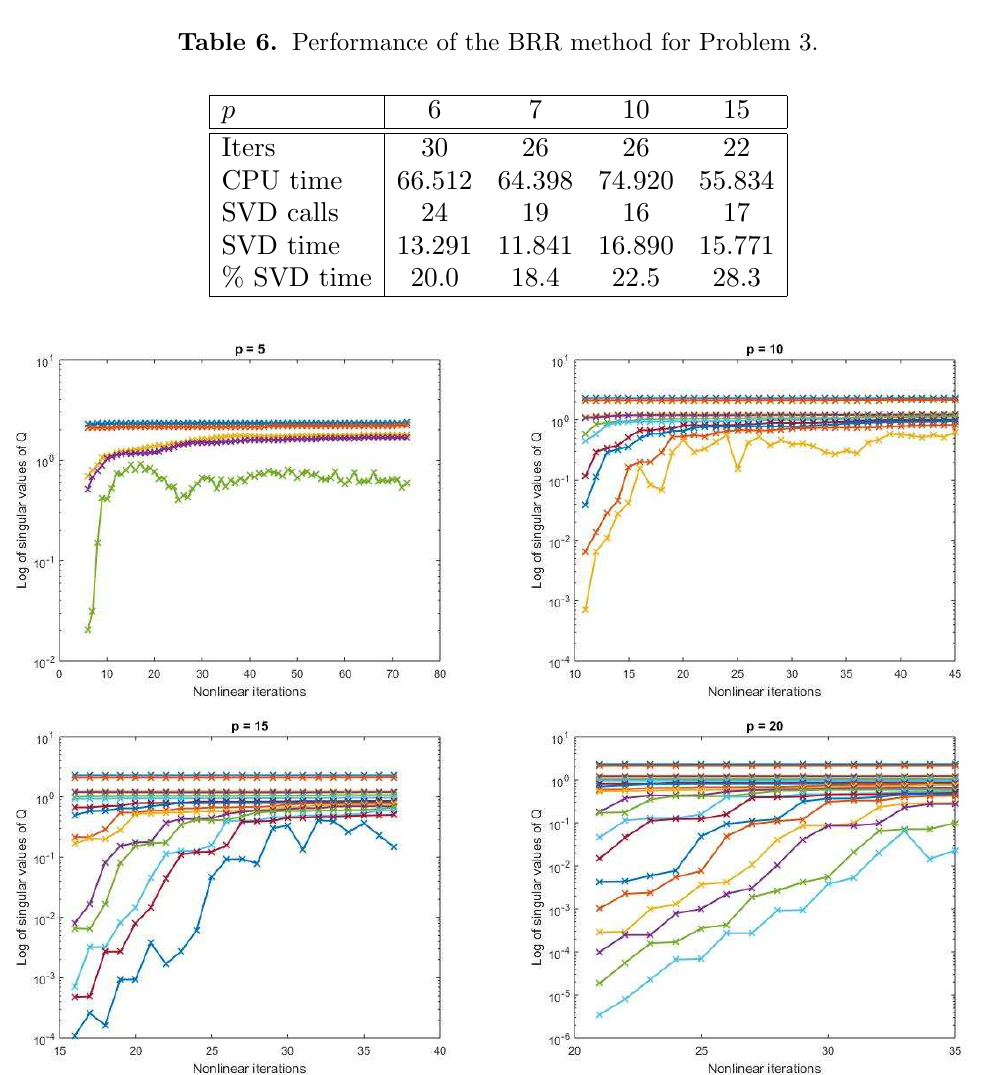
Figure 4. Singular values of the update matrix Q for p = 5, 10, 15 and p = 20 for Problem